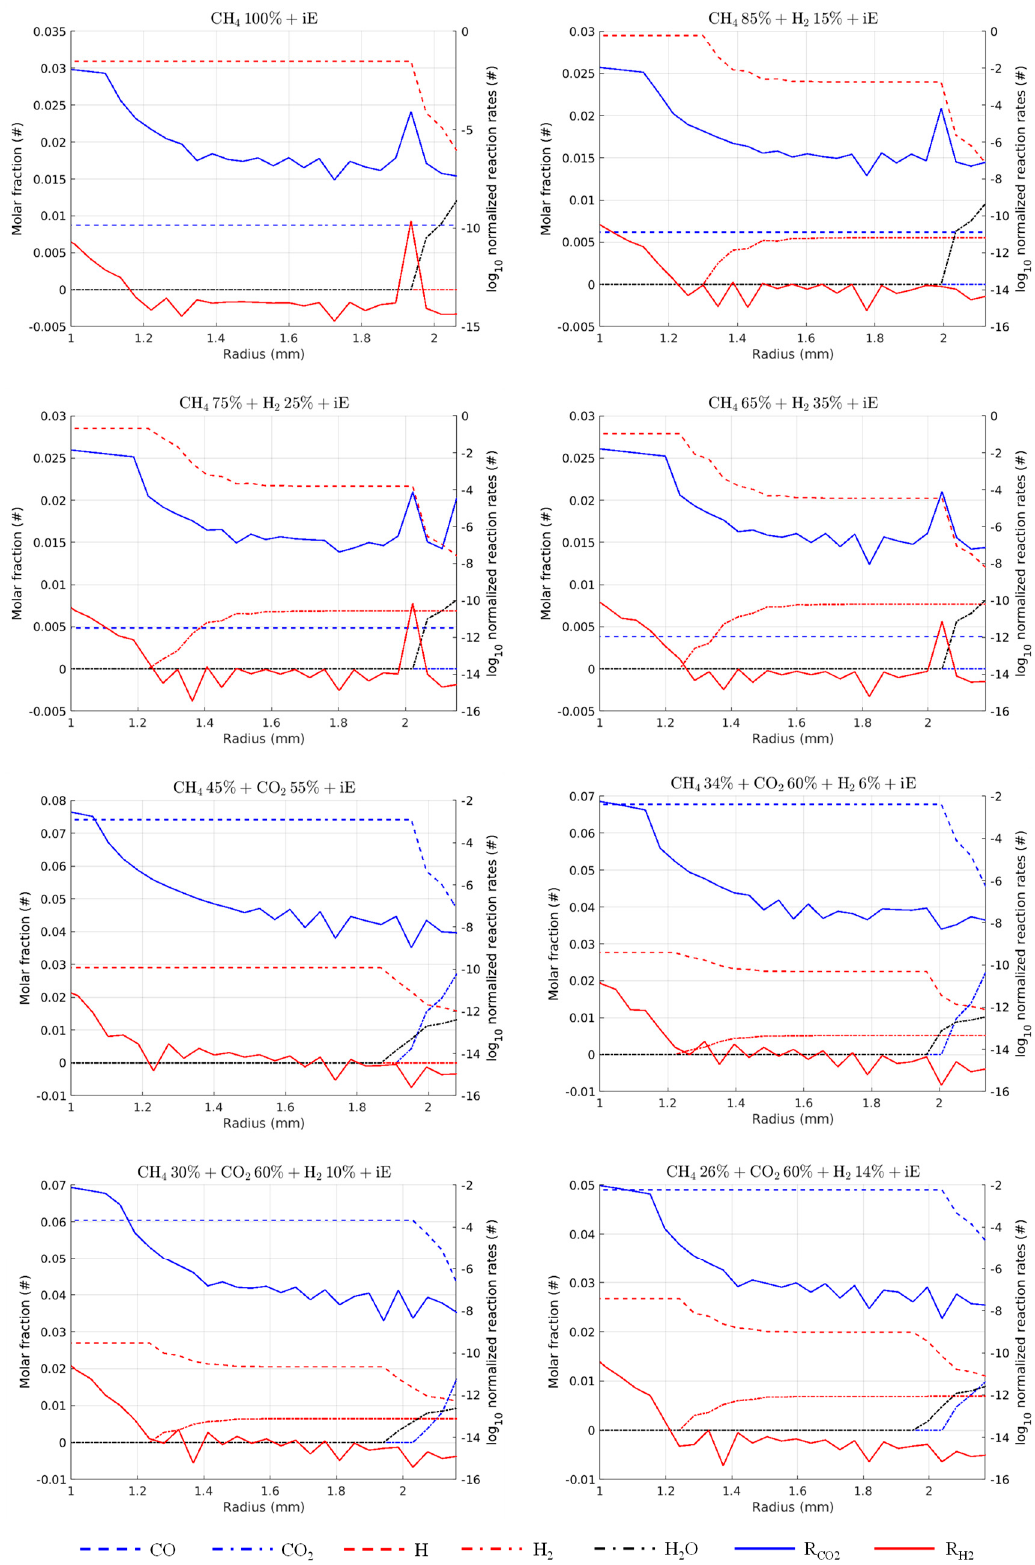
Figure A2. Spatial distribution of carbon monoxide, carbon dioxide, radical hydrogen, molecular hydrogen, water vapor, and of the carbon dioxide and hydrogen dissociation rates. Images for each test fuel (composition reported in the title) at maximum EGR dilution (iE acronym indicating the presence of internal residual EGR only).